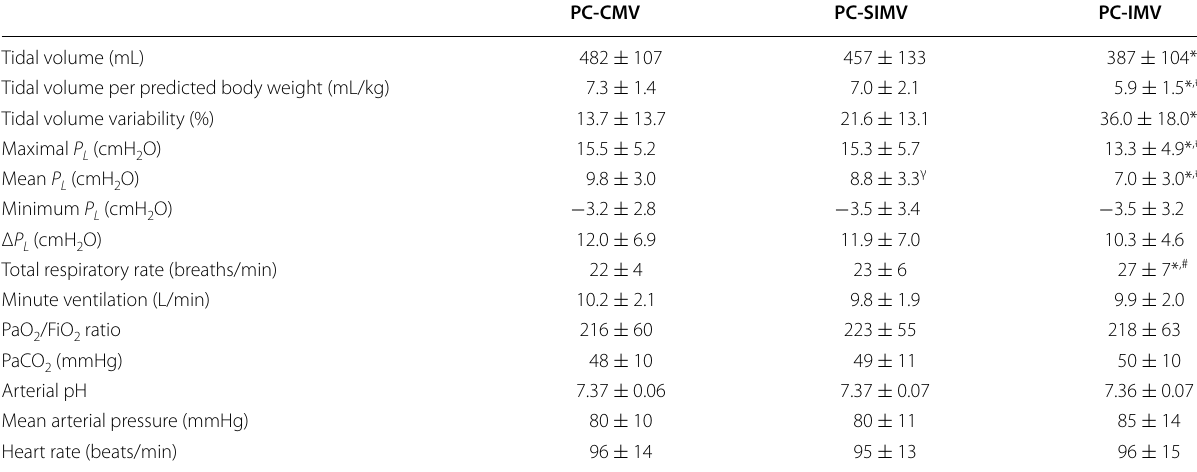
Table 2 Breathing pattern, respiratory and hemodynamic variables during three pressure-controlled modes